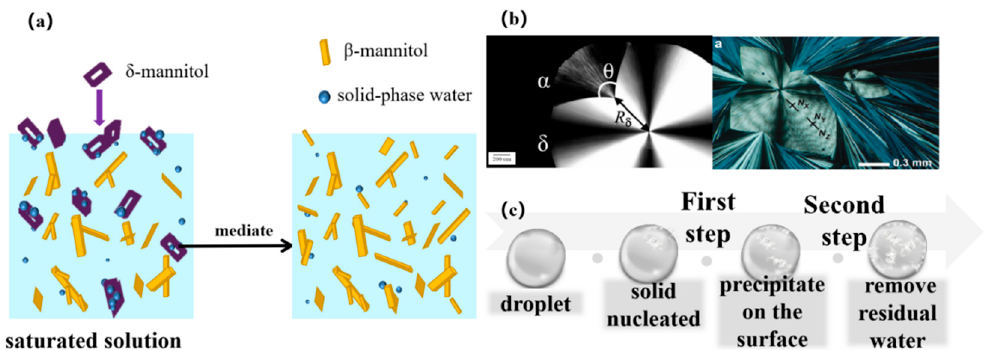
Figure 12. Schematic diagram of possible crystal growth kinetics. ( a ) Solid-phase water mediate ( b ) cross nucleation. Reprinted with permission from Ref. [71]. Copyright 2012, American Chemical Society. Reprinted with permission from Ref. [72]. Copyright 2006, American Chemical Society; ( c ) two stages crystallization in droplet